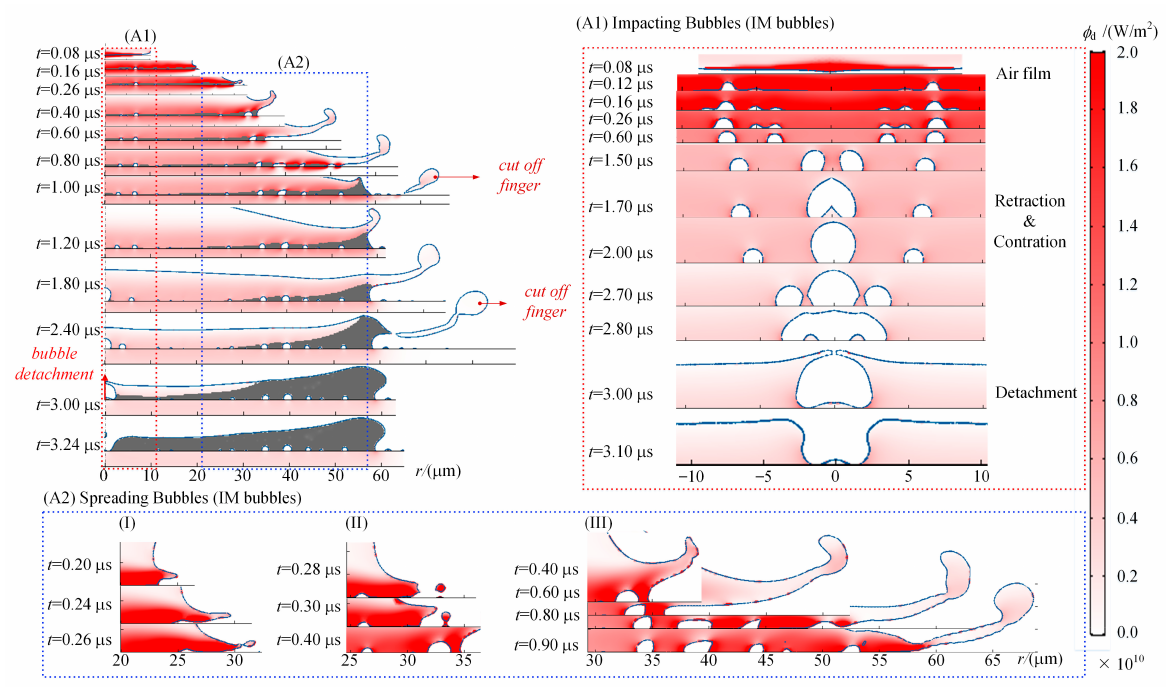
Figure 4. Evolution of a molten nickel droplet’s solidification and air entrapment impacts a smooth stainless-steel substrate (room temperature T 0 = 293.15 K) with an initial speed of 50 m/s. ( A1 ) De- tailed view of the impacting (IM) bubbles entrapping process. ( A2 ) Detailed view of the spreading (SP) bubbles entrapping process: Entrapped by ( I ) falling back of fingers and ( II ) connecting with the splashed secondary droplet; ( III ) cluster of SP bubbles entrapment by falling back of a long finger. φ d is the conductive heat flux. represents the mushy zone of the molten